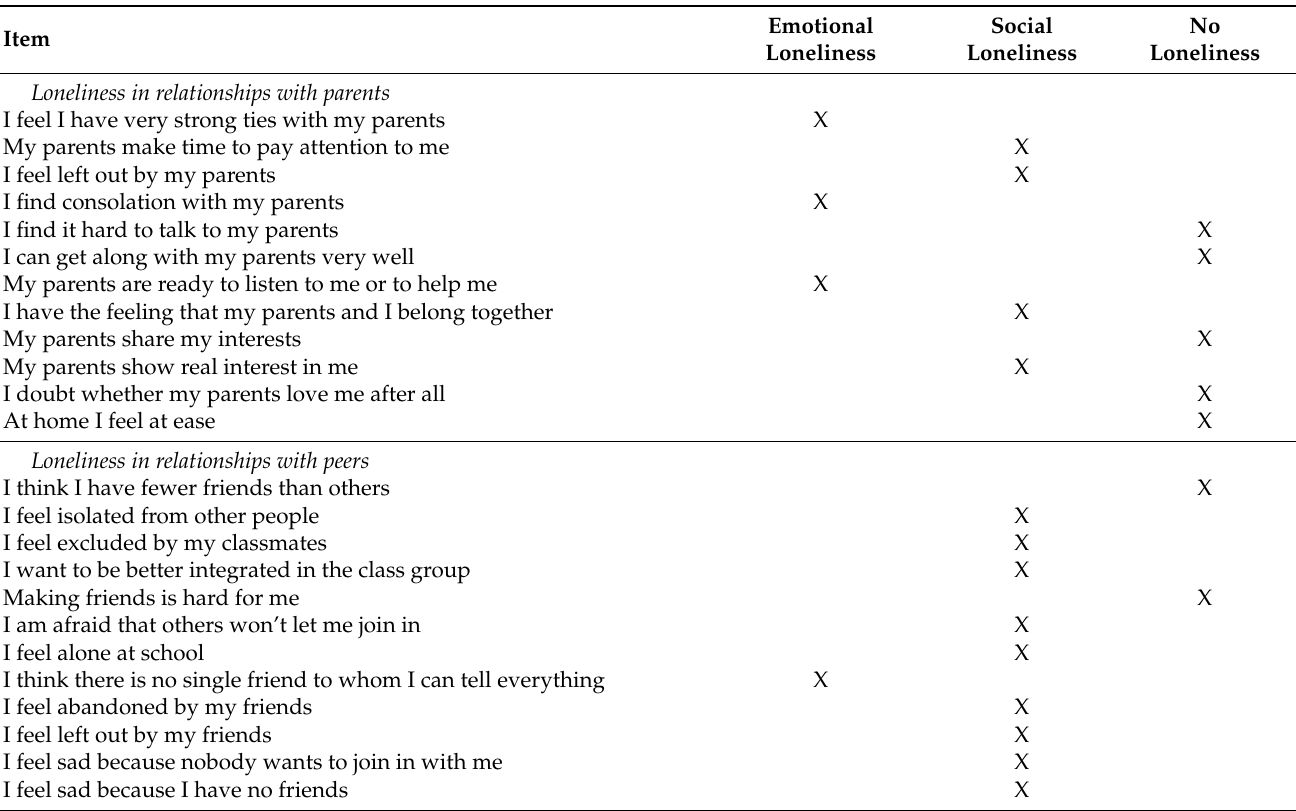
Table 6. Coding of Items of the Loneliness and Aloneness Scale for Children and Adolescents